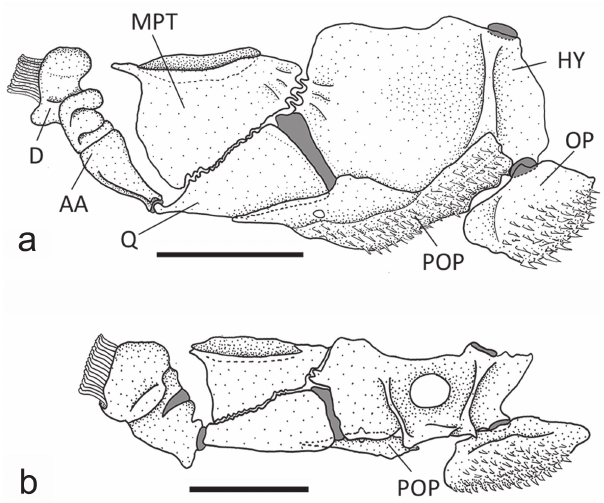
Fig. 5. Suspensorium of: a) Hisonotus maculipinnis , MCP 48067; and b) Acestridium dichromum , ANSP 161494. AA = anguloarticular; D = dentary; HY = hyomandibula; MPT = metapterygoid; OP = opercle; POP = preopercle Q = quadrate. Lateral view, left side, anterior to left. Scale bar = 1